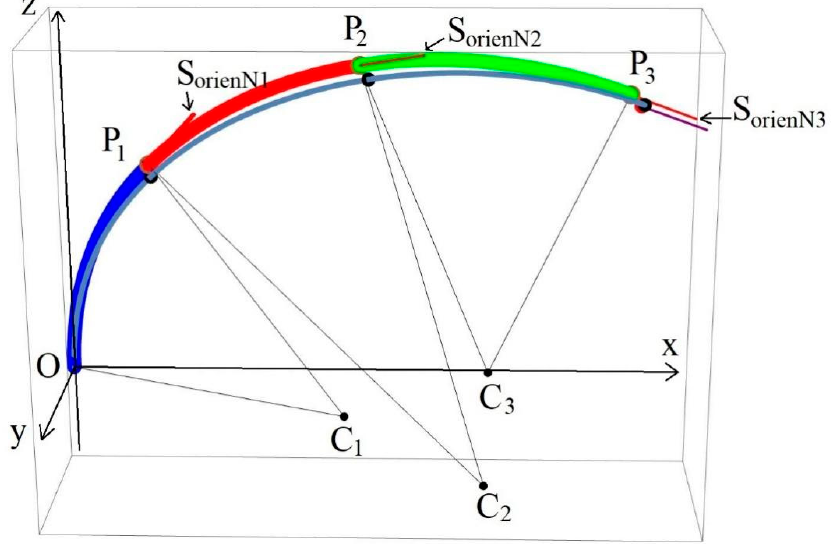
Figure 15. Third segment endpoint (cid:1842) (cid:2871) and orientation vector (cid:1819) (cid:2925)(cid:2928)(cid:2919)(cid:2915)(cid:2924)(cid:2898)(cid:2871) in second segment’s coordi- nation system.